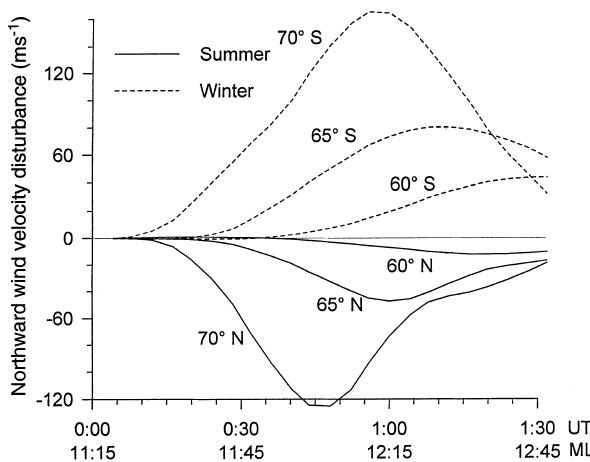
Fig. 7. The time variations of the meridional wind velocity distur- bance ( positive northward) at height 300 km at latitudes 70, 65 and 60 (cid:176) in the summer ( solid lins ) and winter ( dashed lines ) hemisphere (variant 1 of